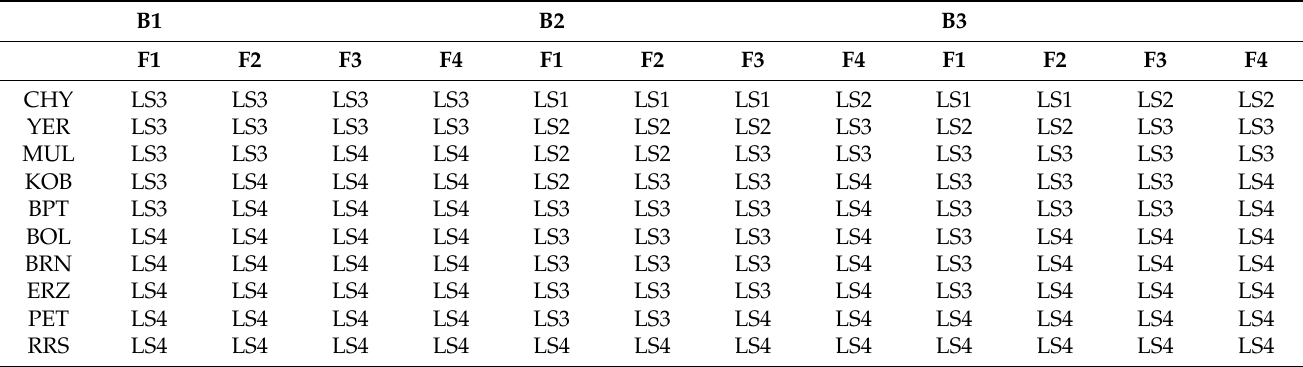
Table 6. Assigned limit states (LS) on the basis of the previous Figures 5–8. The columns represent the condition of exceeding the four limit states for the selected models (models B1, B2 and B3 and for the foure soil conditions: F1, F2, F3 and F4).